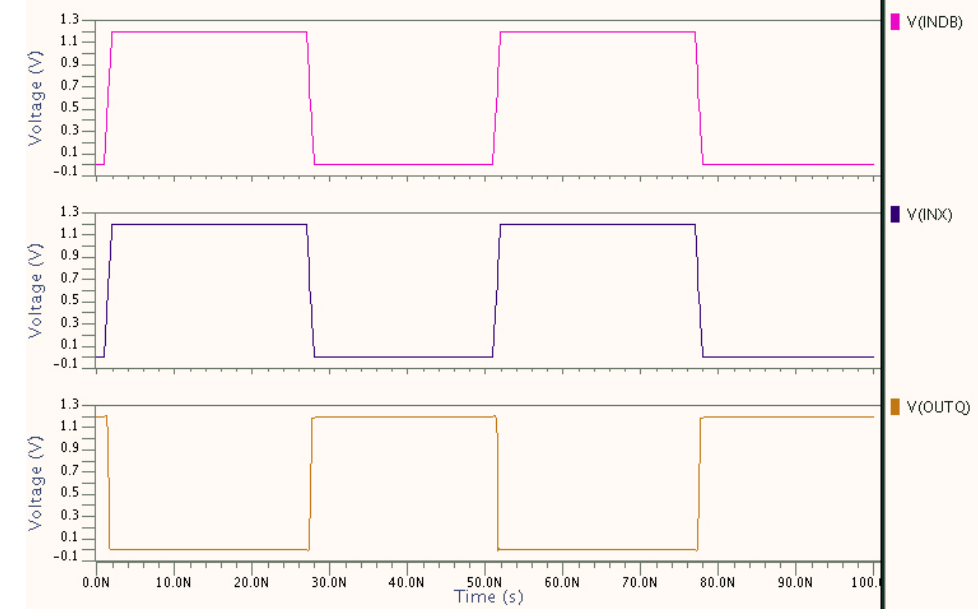
Figure 9. Simulation results of the C-element. Electronics 2016 , 5 , 92